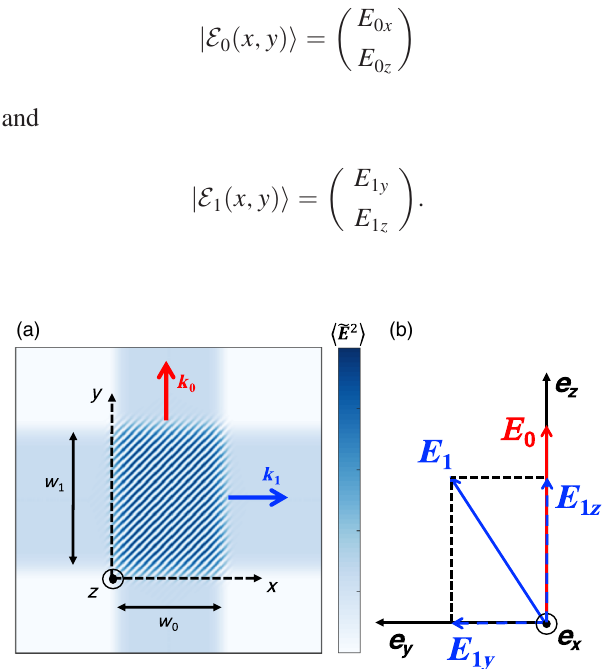
FIG. 3. (a) Geometry for 90° interaction between the two beams. (b) For an s -polarized auxiliary beam (i.e., E 0 parallel to z ), the E 1 component can be modified in amplitude and/or in z phase by the coupling with E 0 , whereas E 1 remains y